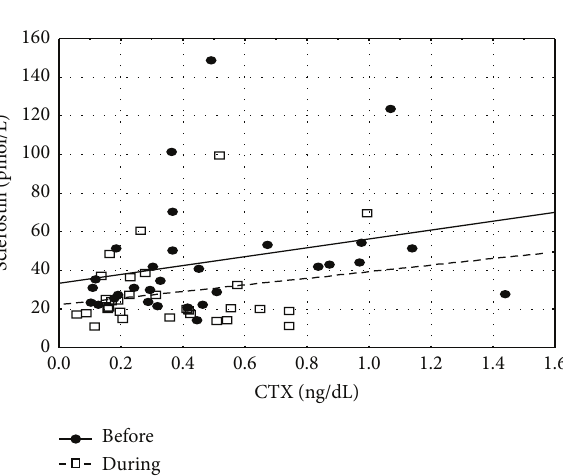
decrease of OC from 35.6 ± 22.0 to 27.0 ± 14.3 ng/mL, 𝑝 = 0.00004 , and CTX from 0.49 ± 0.35 to 0.35 ± 0.23 ng/dL, 𝑝 = 0.0016 . In contrast, PTH concentrations increased from 29.3± 14.9 pg/mL to 39.8 ± 19.8 pg/mL, 𝑝 = 0.0005 (Table